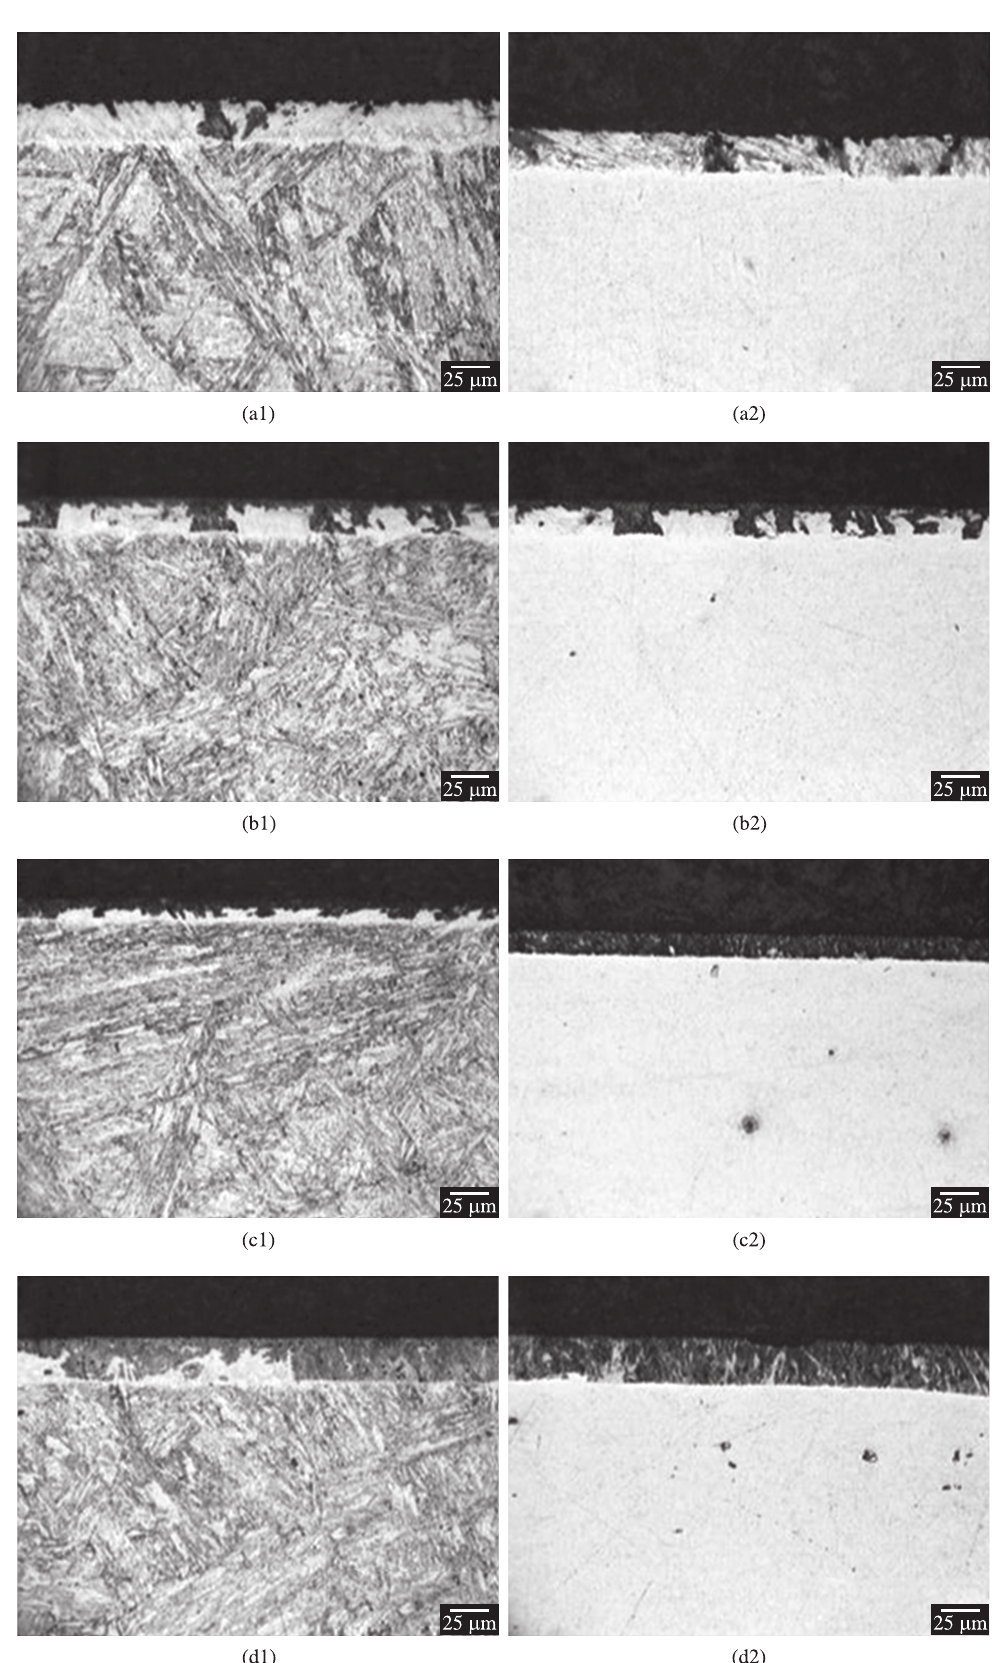
Figure 2. Micrographies for different nitriding conditions: a) 20% N with Vilella; and Index 2: etched with Nital